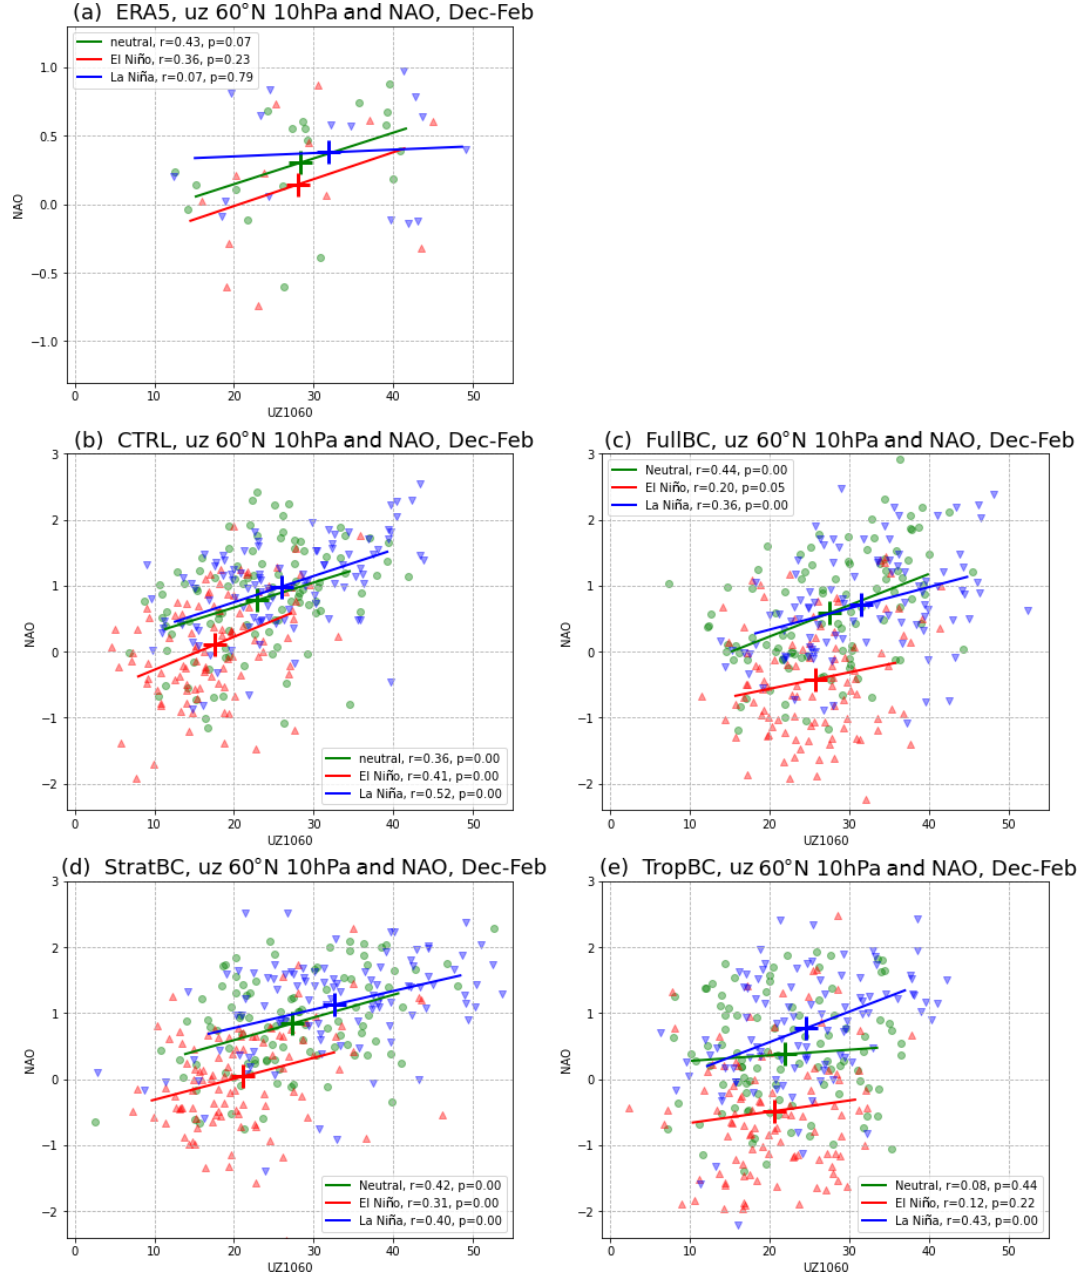
Figure 3. Scatterplot with regression line of mean DJF values of UZ at 60 ◦ N and 10hPa and the NAO index, for (a) ERA5 (1950–2021), (b) CTRL, (c) FullBC, (d) StratBC, and (e) TropBC. Neutral years are green, El Niño years are red, and La Niña years are blue. The large crosses indicate the mean value for each El Niño, La Niña, and neutral experiment. Correlation and p values are shown in the